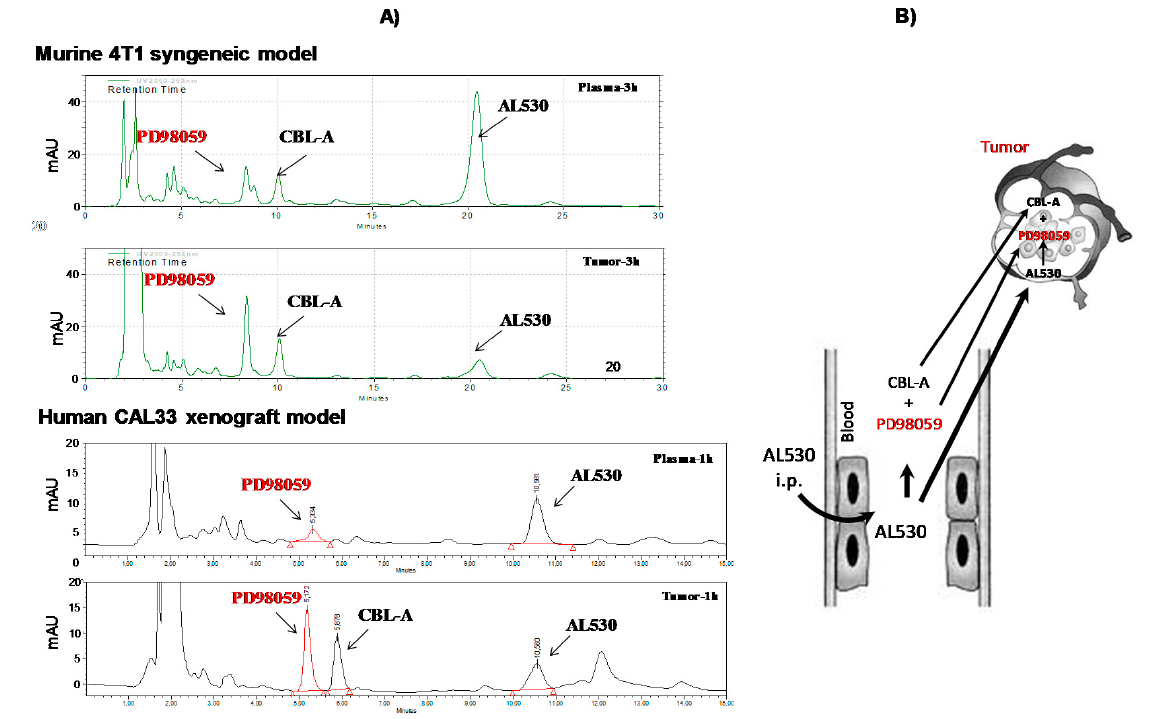
Figure 4. ( A ) In vivo hydrolysis of AL530 in 4T1 mouse mammary tumors (top panel) and human head and neck tumors generated from the CAL33 human xenograft in nude mice (bottom panel). Each chromatogram represents the analysis of plasma or tumor extract from a mouse treated with 100 mg/kg of AL530 (i.p.) after 3 h (4T1 model) and 50 mg/kg (i.p.) after 1 h (CAL33 model). Following mice sacrifice, plasma and tissue were collected and stored at − 80 ◦ C until the day of analysis by HPLC as described in the Materials and Methods section. Consistently higher levels of PD98059 were released in tumor tissues than in plasma. ( B ) Proposed model for the absorption and distribution of AL530 and the localization of its hydrolytic conversion to PD98059 + CBL-A. Table 3. ( A ) Pharmacokinetic parameters of AL530 and the released MEK inhibitor PD98059 and ( B ) the release ratio of PD98059 and AL530 in-between tumor and plasma.